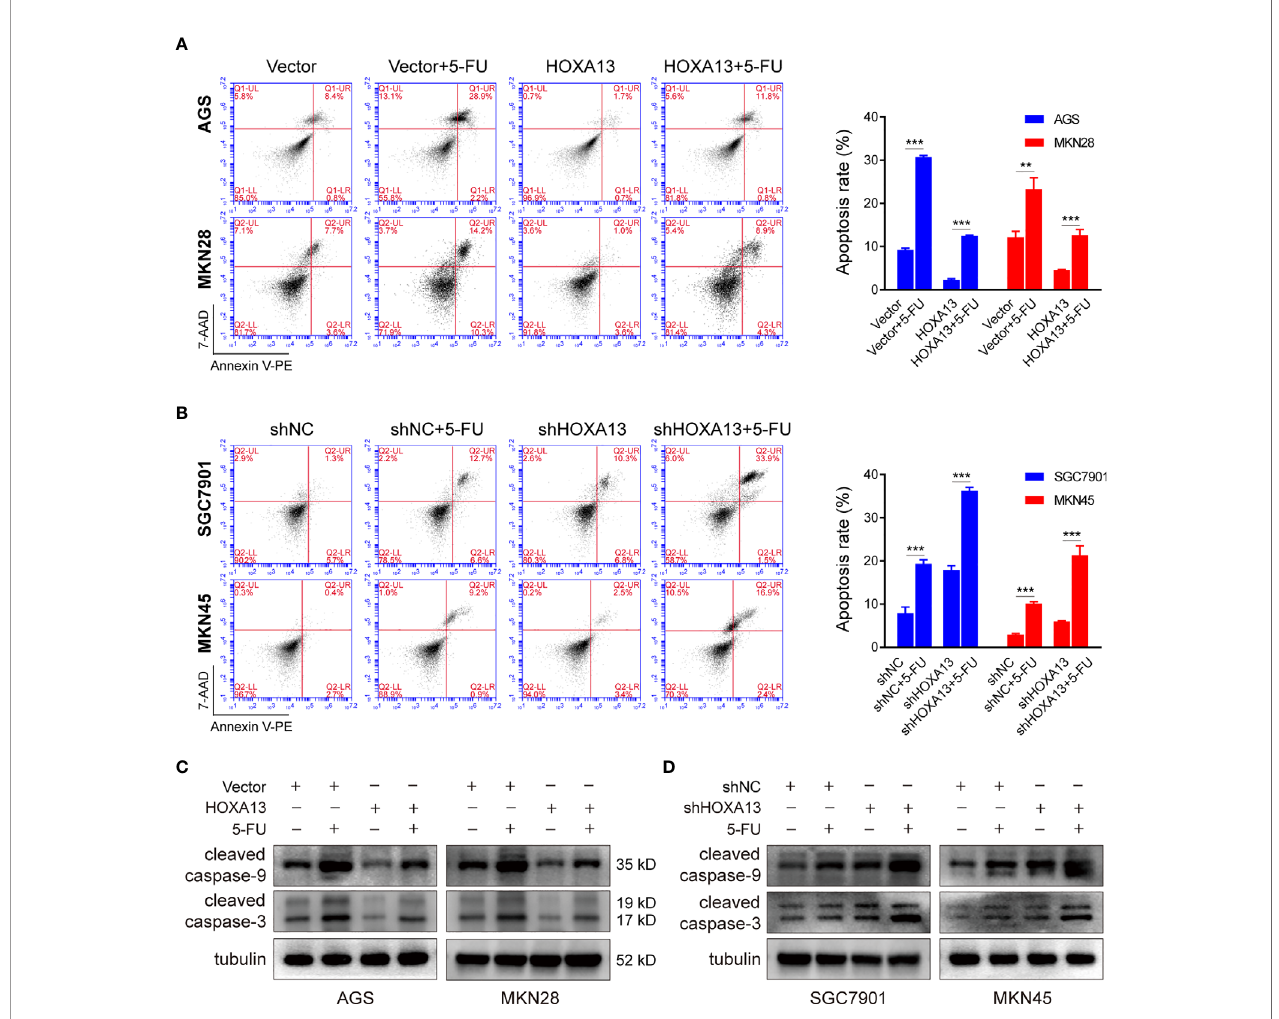
FIGURE 3 | HOXA13 knockdown exacerbates apoptosis induced by 5-FU in GC cells. (A, B) Flow cytometry assays detected the effect of altered HOXA13 expression and 5-FU treatment on GC cells apoptosis. (C, D) The protein levels of cleaved caspase-9 and cleaved caspase-3 in GC cells were determined by Western blot. ** P < 0.01, *** P <